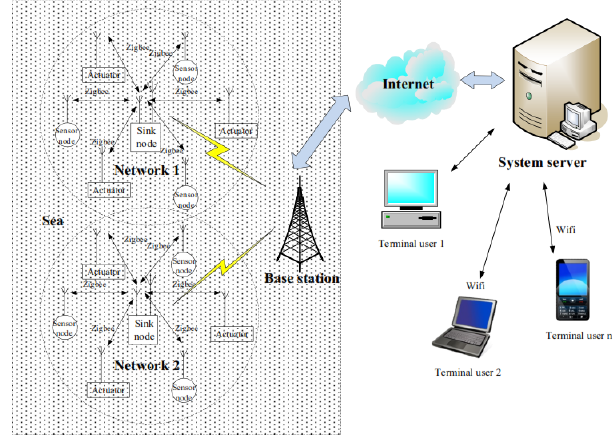
Figure 8 . Networking layer for WSN in marine environment monitoring